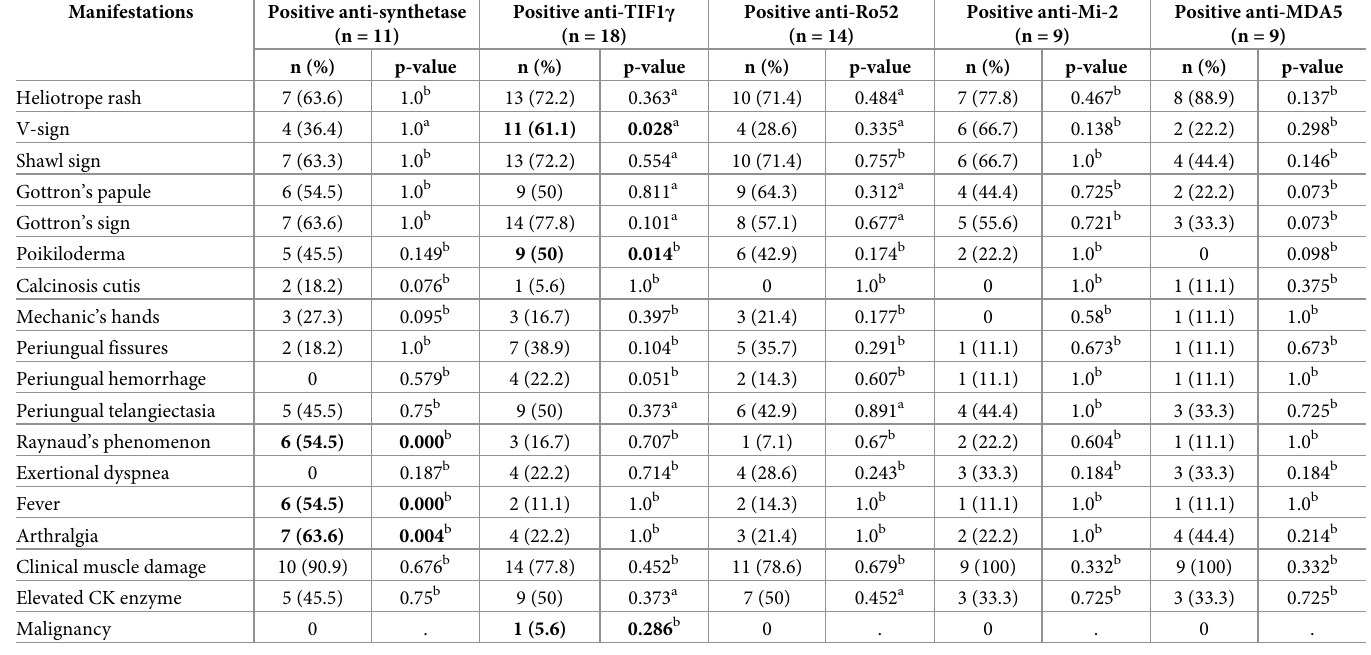
Table 5. Associations of autoantibodies with